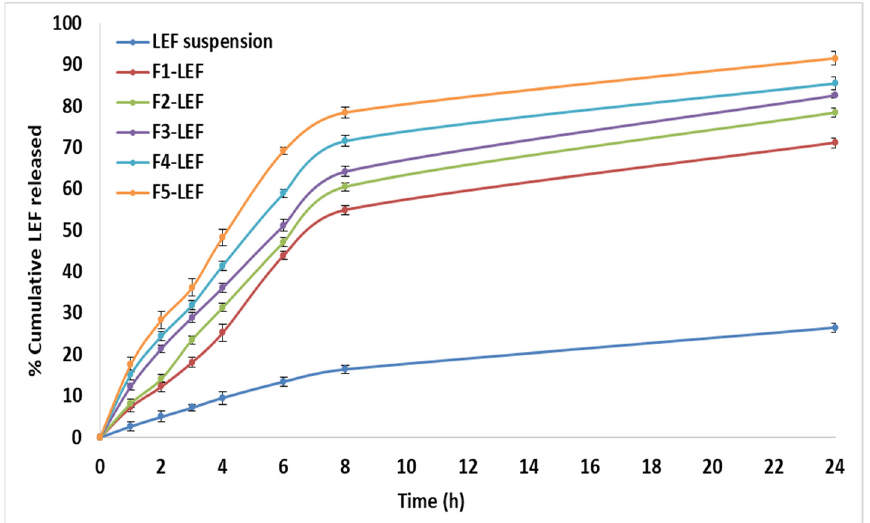
Figure 5. Cumulative percentage LEF released from LEF loaded EMLs.